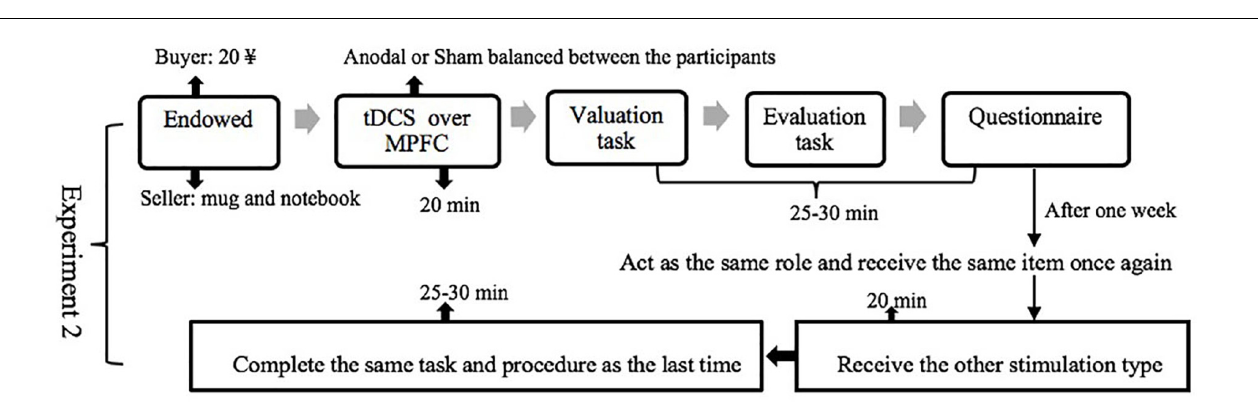
FIGURE 4 | Schematic representation of the experimental design in Experiment 2. The participants had to come to the lab twice and complete the same task and procedure as that in the Experiment 1 after receiving one of two stimulation types (anodal or sham).